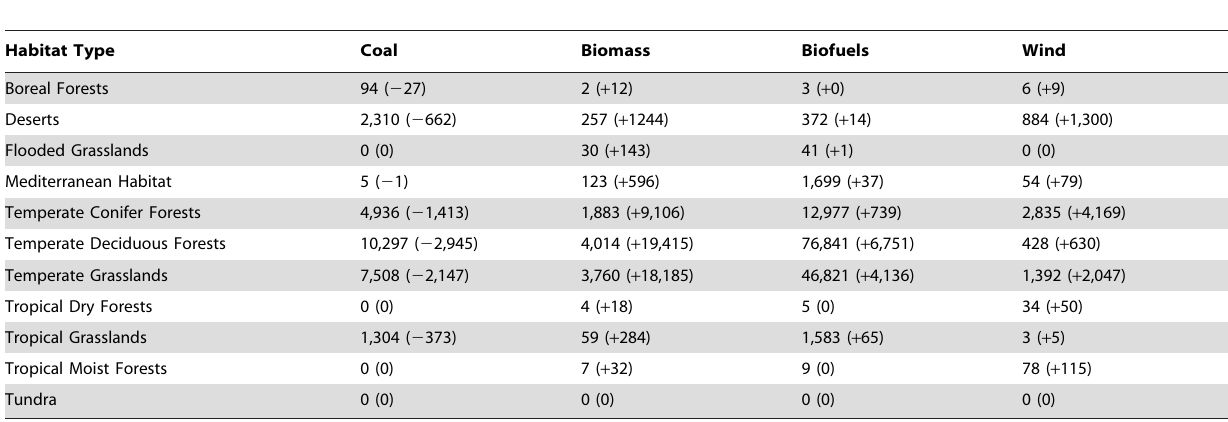
Table 1. Minimum new area (km 2 ) of habitat types impacted in the